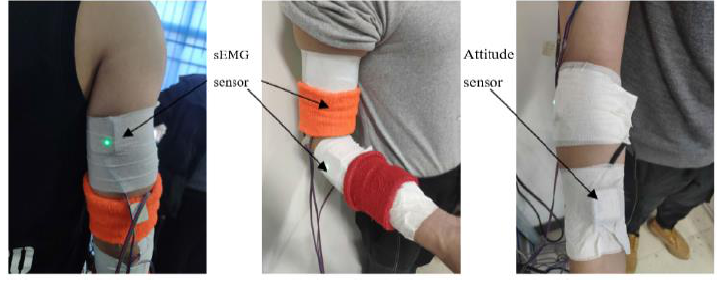
Figure 2. Joint angle prediction experiment platform.